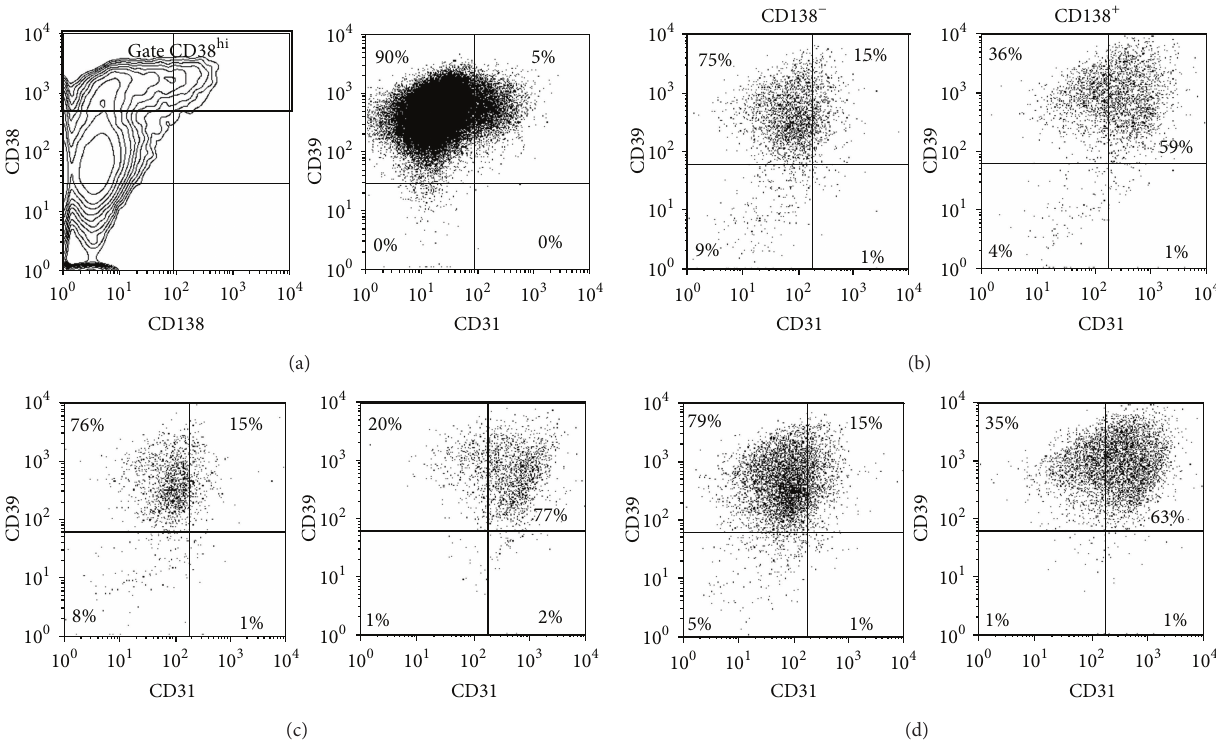
Figure 5: High frequency of CD39 + cells among the expanded B lymphocyte population. Viable cells were analyzed for CD31 and CD39 expression before their transfer into differentiation conditions (D0). (a) Profiles of total viable cells according to CD38 and CD138 (left) and to CD31 and CD39 (right) are shown. The CD 38 hi CD138 +/− cells represented 22 ± 3 % of the cell population in the presence of CD154 interaction (b) and 25±6 % in the presence of CD70 (c). They represented 14±2 % of the population when being in the simultaneous presence of both interactions (d). These cells were further analyzed for their expression of CD31 and CD39 according to their expression of CD138 as indicated in (b, c, and d). These results are representative of 11 and 10 independent experiments for the stimulation with L4.5 cells (b) or 3H7 cells (c), respectively. The results in (d) are representative of three independent